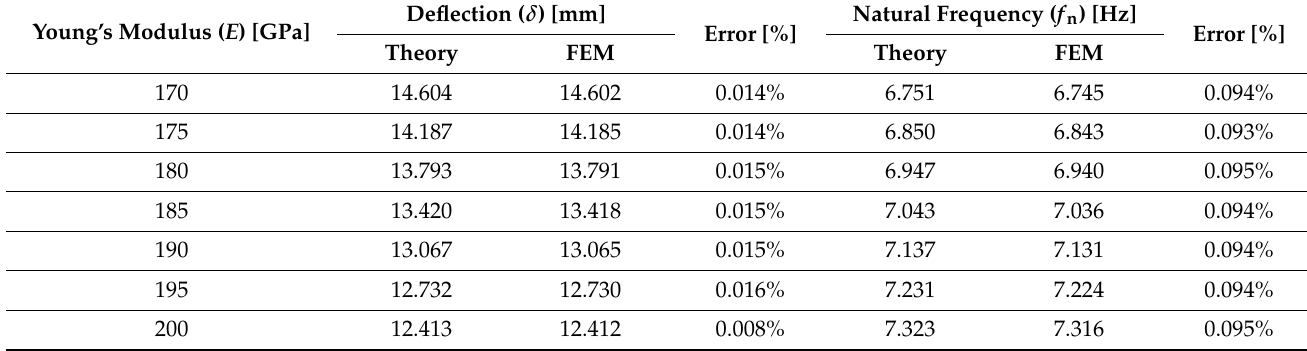
Table 3. Static deflection and natural frequency values of steel as a function of E calculated using theoretical and Ansys numerical analysis.